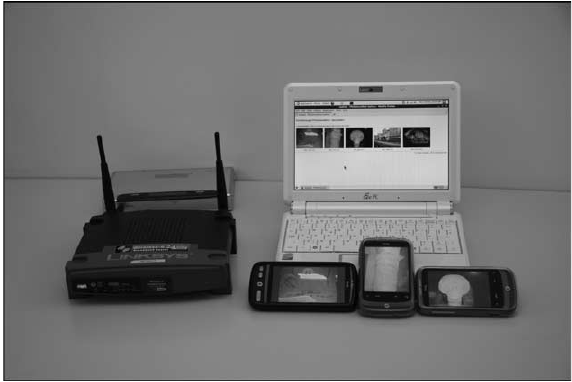
Figure 6. An example photomarathon toolset for collecting photos from a set of Android mobile phones, comprising of a wireless router, a netbook computer and some